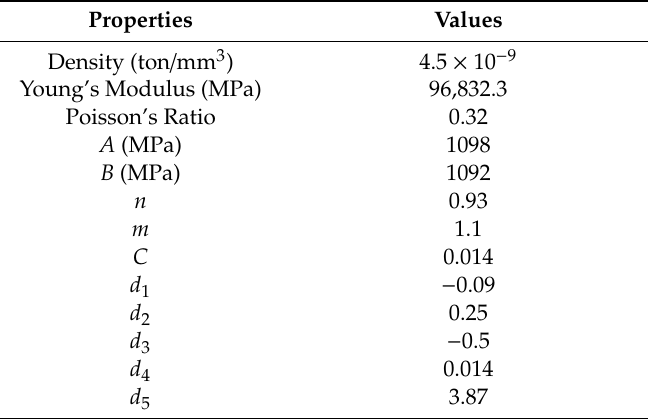
Table 2. Mechanical properties and materials constant in the Johnson–Cook (J–C) model for titanium alloy